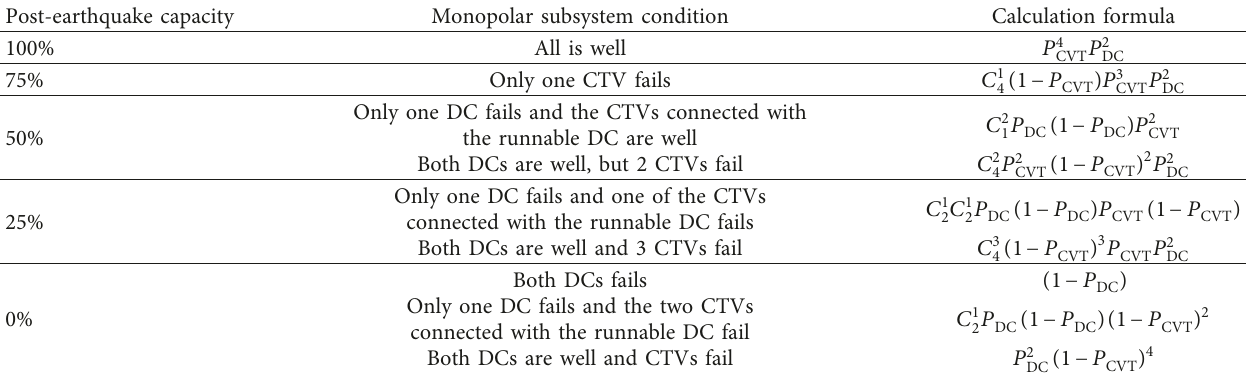
Table 1: Seismic reliability calculation of monopole